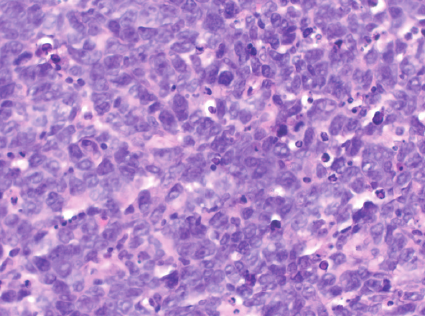
Figure 5: Case 2—hematoxylin and eosin stain (H&E) of liver biopsy(40Xresolution)revealingdiffuselargeBcelllymphomawith pleomorphic cells with scant